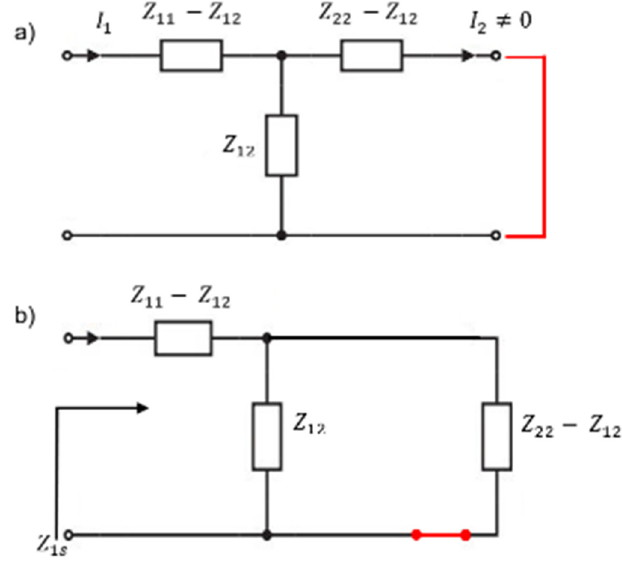
Figure 11. ( a , b ) shows the third measurement. Figure 11. ( a ) and ( b ) shows the third measurement.